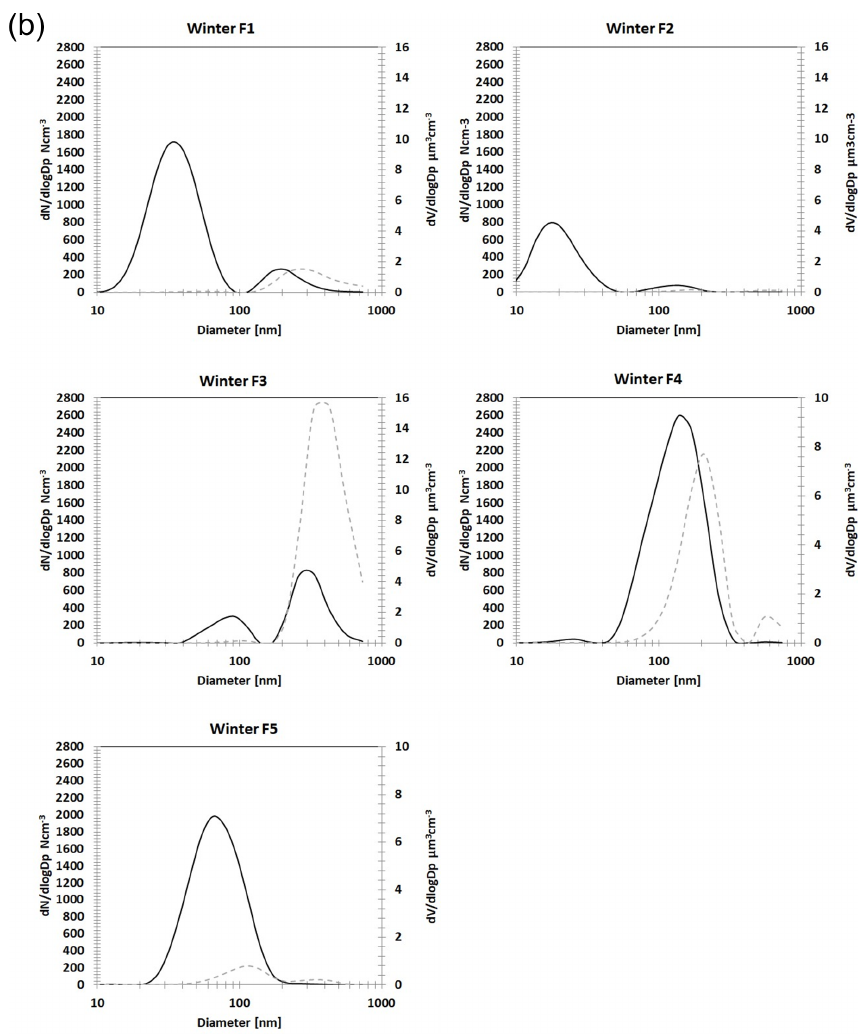
Figure A12. PNSD factor profiles for summer (a) and winter (b) campaign. NSD (black line, y axis on the left), volume size distribution (dashed grey line, y axis on the right). The volume size distribution was recalculated from the NSD assuming spherical particles.